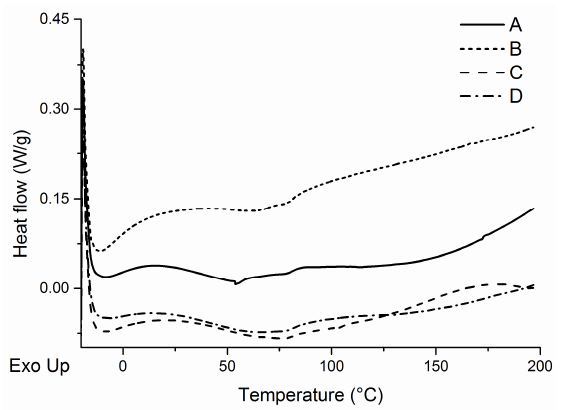
Figure 9. DSC curves of dried latexes containing 200 mg of total monomer weight with ( A ) 80 wt.% of tung oil, ( B ) 70 wt.% of tung oil, ( C ) 55 wt.% of tung oil, and ( D ) 40 wt.% of tung oil. All samples were subjected to an initial cure step at 100 °C for 24 h, followed by a drying process in a vacuum oven at 60 °C for 24 h, and a post cure step at 140 °C for 2 h.